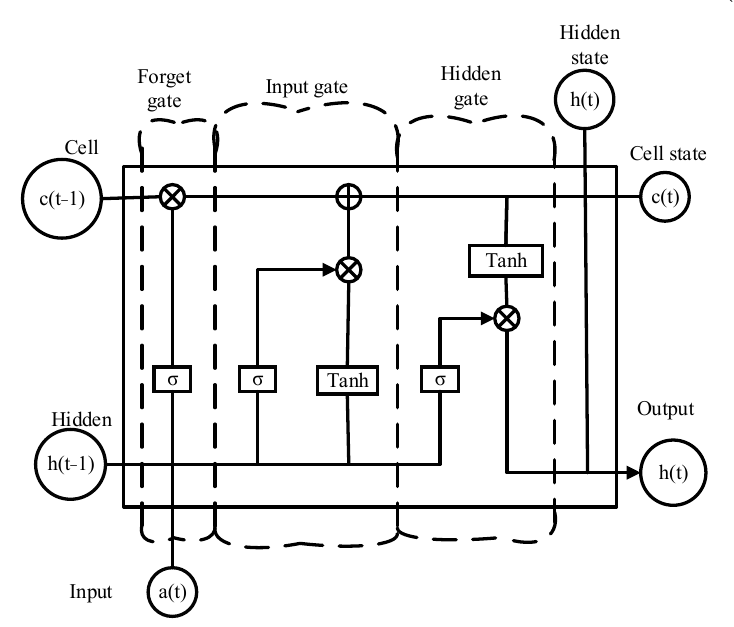
Figure 4. The cell structure of Long-Short Term